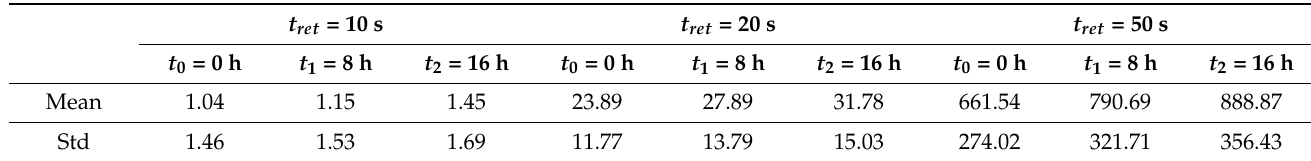
Figure 7. Retention error distribution curve across groups of rows for 0x00 pattern in a Hynix 2 GB DRAM module. Table 2. Mean and standard deviation of the retention error distribution curve for 0x00 pattern in a Hynix 2 GB DRAM